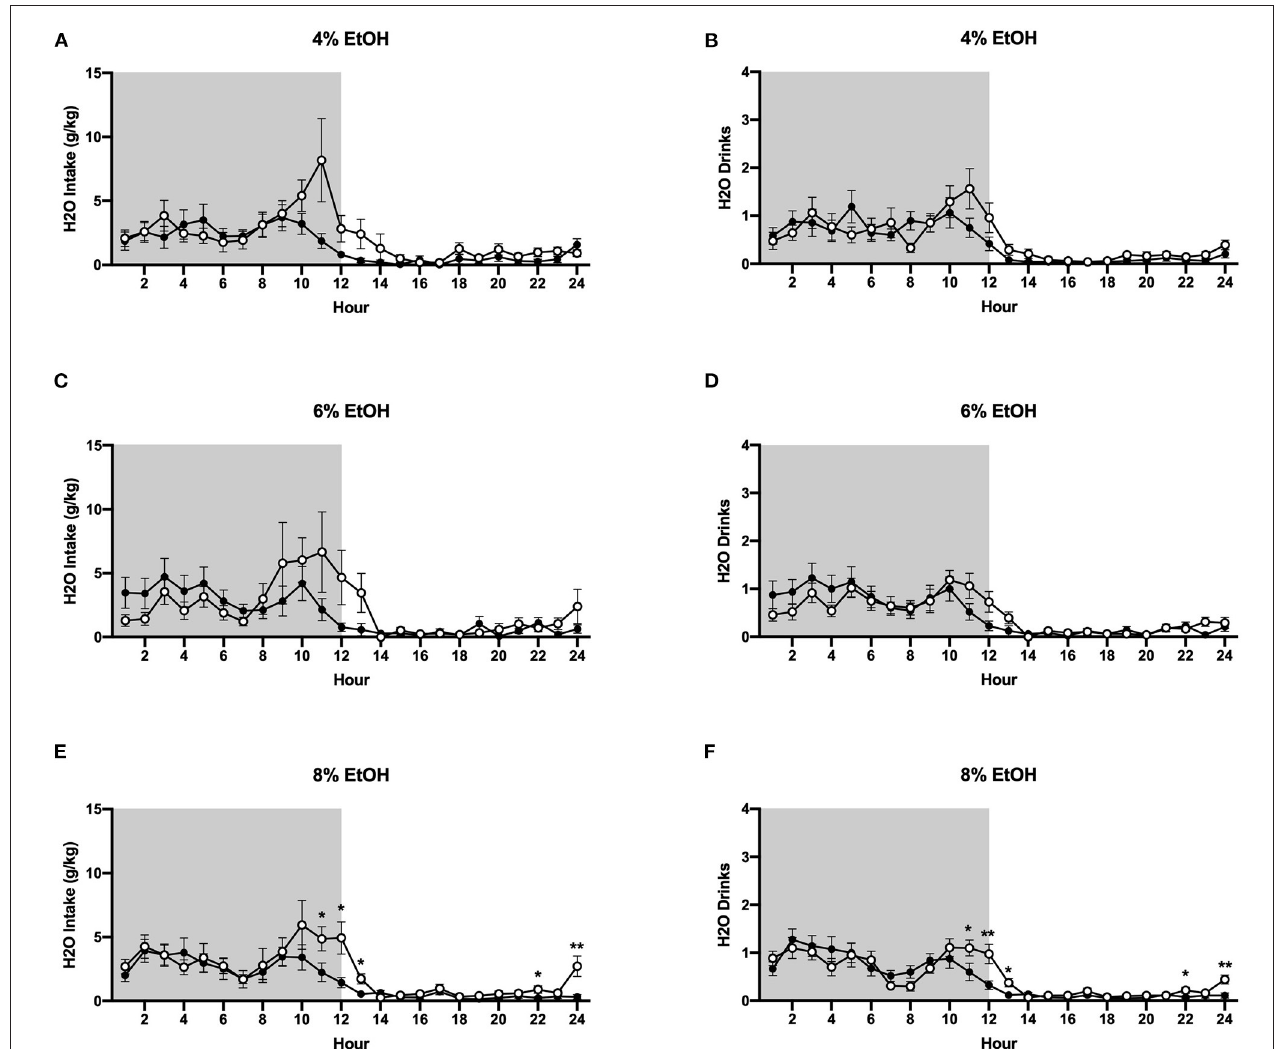
FIGURE 5 | Hourly baseline water data. (A) Water intake in g/kg when 4% ethanol was available. (B) Number of water drinks when 4% ethanol was available. (C) Water intake in g/kg when 6% ethanol was available. (D) Number of water drinks when 6% ethanol was available. (E) Water intake in g/kg when 8% ethanol was available. (F) Number of water drinks when 8% ethanol was available. Socially-housed mice had significantly higher water intake and number of water drinks than individually-housed mice, but only at the 8% ethanol concentration. * p < 0.05, ** p < 0.01, compared to opposite housing condition. Data represented as mean ± SEM. n = 24/group. Shaded regions are representative of the dark